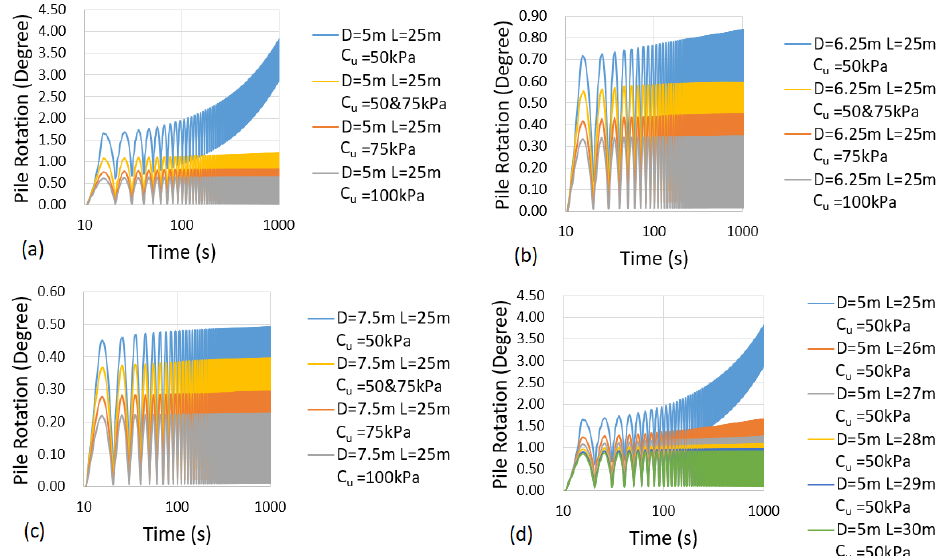
Figure 13. Time History of the rotation for the 17 simulations. ( a ) D = 5 m, L = 25 m. ( b ) D = 6.25 m, L = 25 m. ( c ) D = 7.5 m; L = 25 m. ( c ) D = 5 m, L = variable as